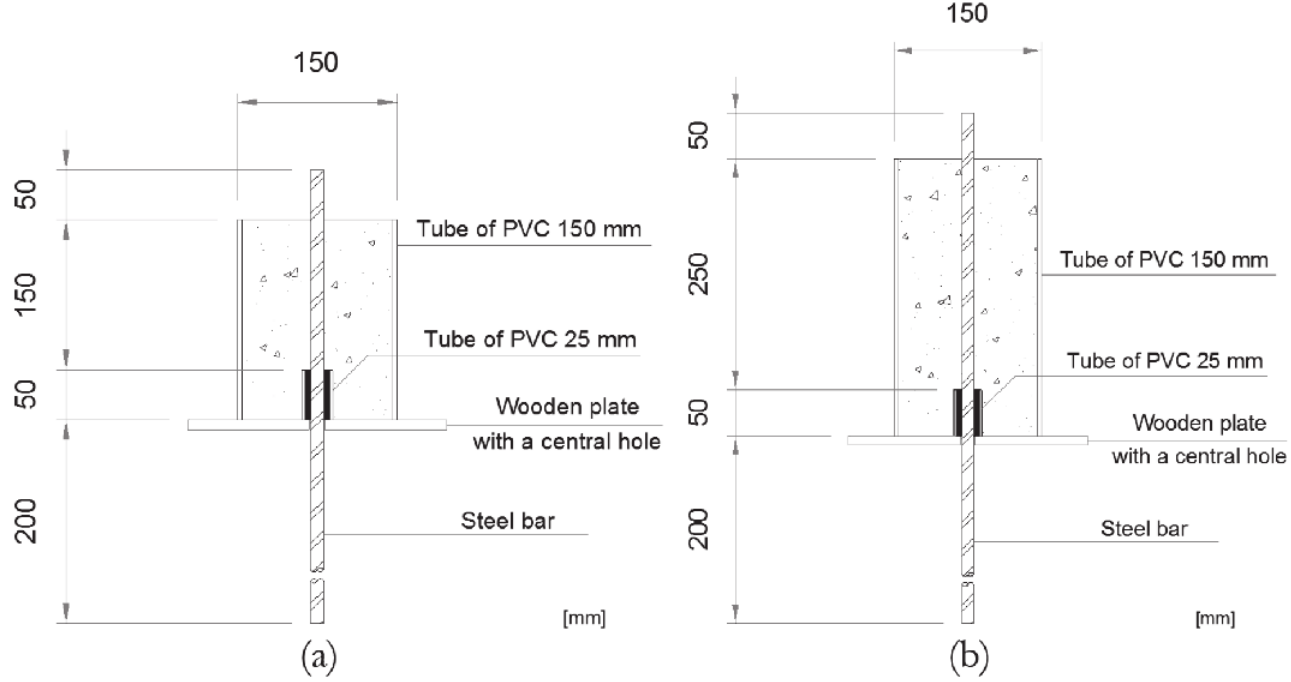
Molds cross section: preliminary test and 1 st batch of SLCEB (a); 1 st batch of OC